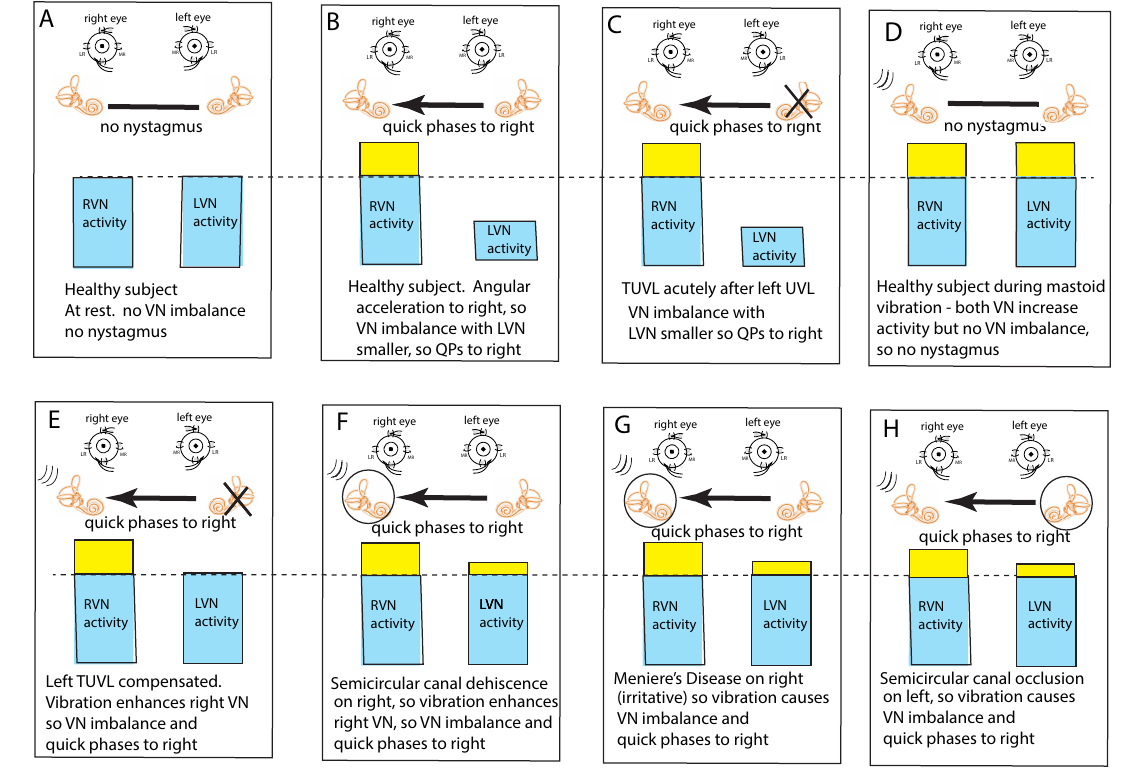
Figure 3. The “imbalance principle”—showing the relative average neural activity of the two vestibular nuclei (VN— histograms) in various stimulus conditions resulting in nystagmus with the direction shown by the black arrow. The yellow areas show the increased activity resulting from the procedure. These histograms are representations of the level of neural activity in the vestibular nuclei in eight separate conditions ( A – H ). The thin dashed line represents the average level of activation of a healthy subject at rest. The three lines (in D – H ) indicate the vibration stimulus which, even though it is applied to only one labyrinth, is an effective stimulus to both labyrinths simultaneously because of the fast efficient conduction through the skull. In healthy people it is presumed that the average neural activity in the two nuclei is in balance ( A ) with no nystagmus. ( B ) A horizontal head angular acceleration to the right will activate the right VN and simultaneously decrease the activity of the left VN. This imbalance results in nystagmus with slow phase eye velocity away from the right side and quick phases towards the right side. An observer perceives the quick phases and so the nystagmus appears to beat towards the right side (and away from the left side). A patient acutely after left unilateral loss ( C ) has a large imbalance in neural activity so quick phases beat to the right. ( D ) If a healthy person is subject to vibration of either mastoid it will generate increased neural activity in both VN ( D ) because canal neurons in both labyrinths will be activated, but there will be no asymmetry in average VN neural activity and so no nystagmus. The circled labyrinths in ( F – H ) show the affected